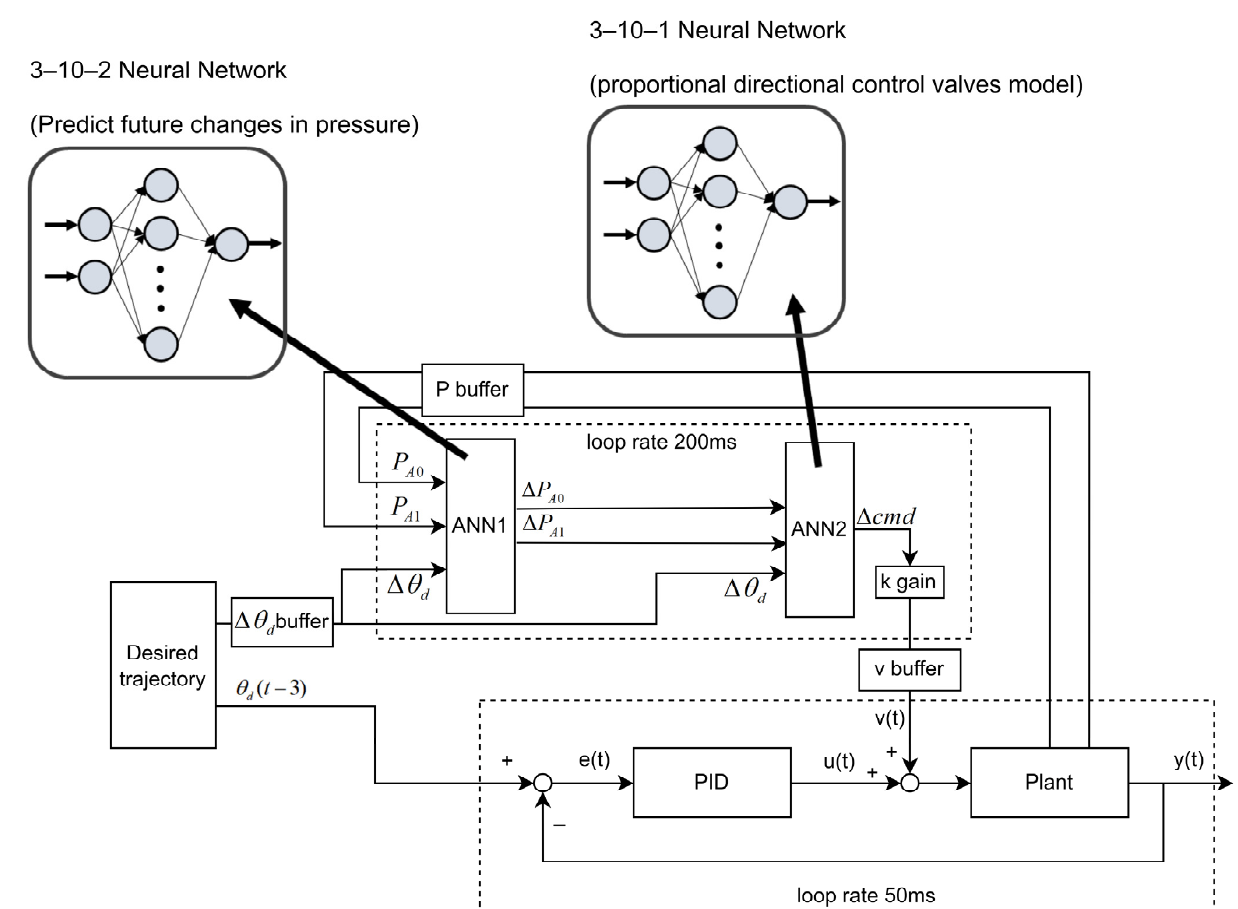
Figure 15. ANN-feedforward with PID controller.